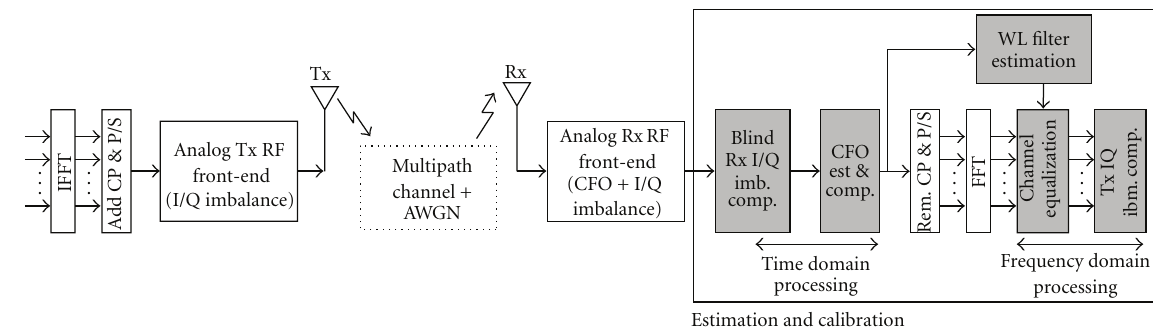
Figure 6: OFDM system model with sparse pilot compensator